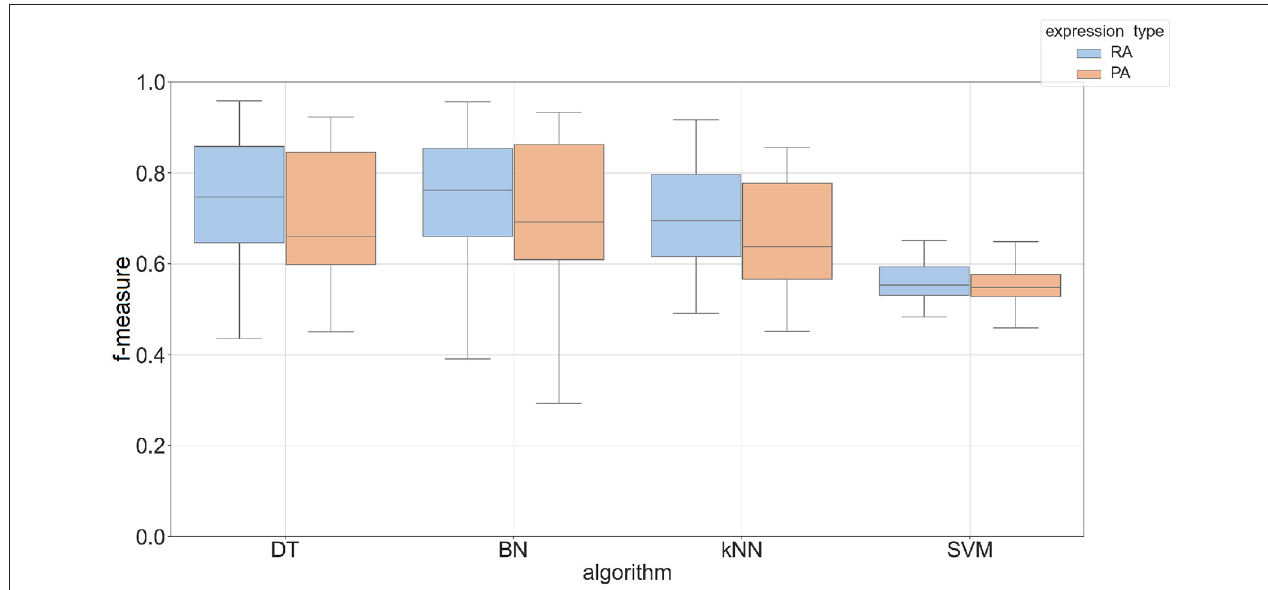
FIGURE 3 | Box plot of F-measures for Phase II classifiers based on two expression types (RA, mRNA abundance; PA, protein abundance). The input type was DNA promoter sequence using a k -mer size of 5. Each plot shows the interquartile range and mean of F-measures across all tissues using the top 5–30% and bottom 5–30% of expression cutoffs. The x-axis is labeled by the implementation names of the four machine learning approaches (DT, Decision Tree; BN, Bayesian Network; kNN, k-Nearest Neighbors; SVM, Support Vector